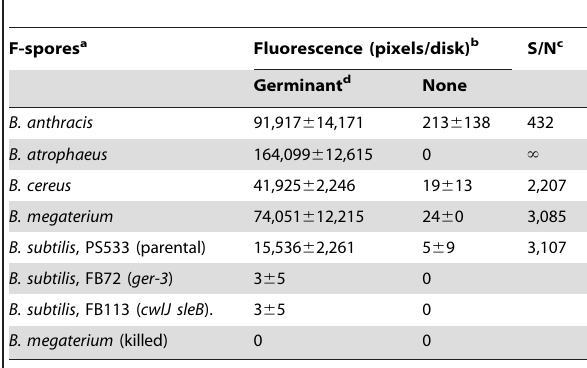
Table 1. Fluorogenic ability of F-spores constructed from different Bacillus spores.